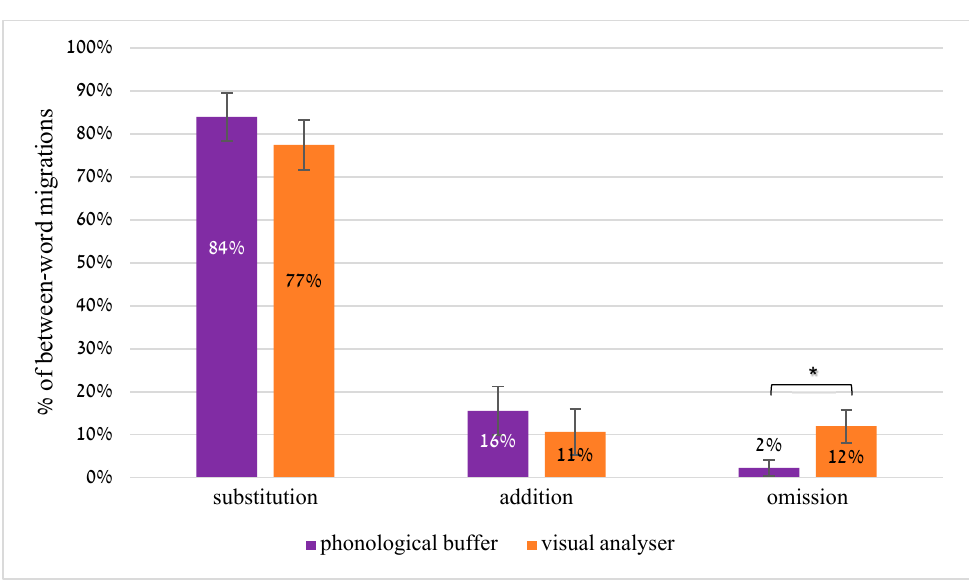
Figure 5. Percentages of between-word errors of the various types out of the total consonantal between-word errors. * p = 0.018